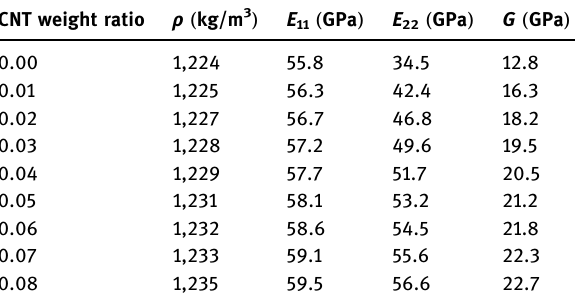
Table 5: Mechanical properties of CNTFPC panels for increased CNT weight ratios using multi - scale analysis